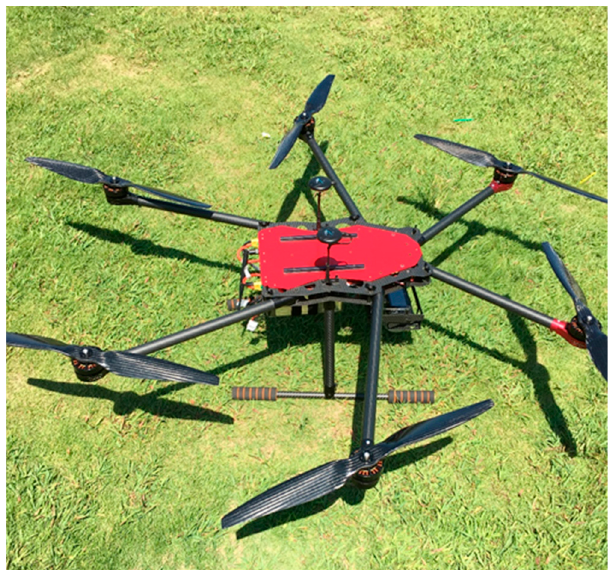
Figure A1. The six rotor-wing UAV system (ZR-66B, SOUTH, China).